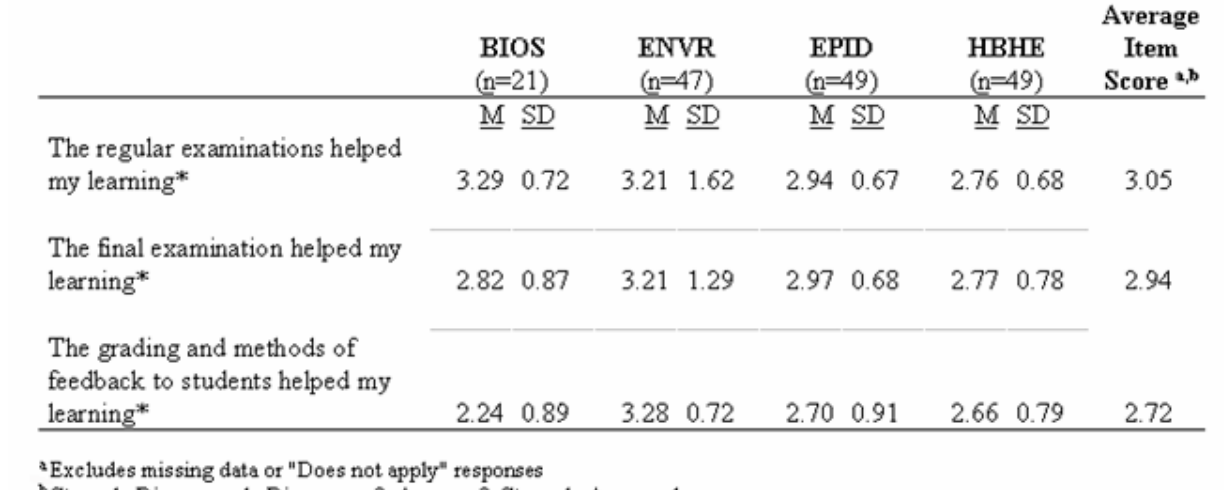
Table 5. Assessment of Student Learning